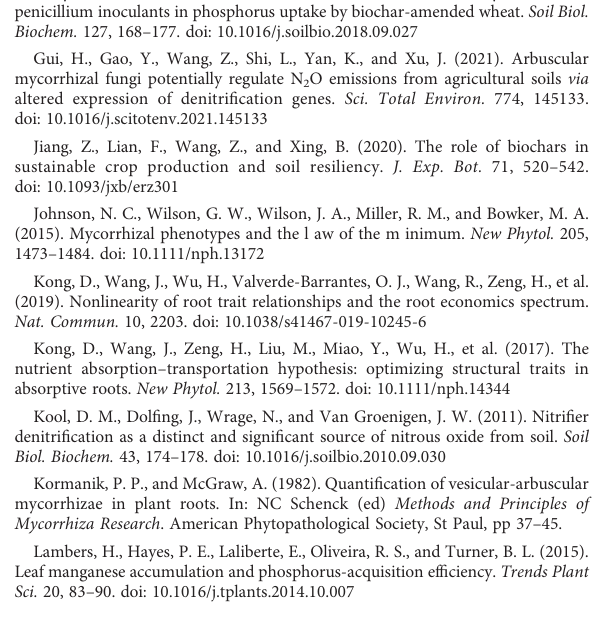
SUPPLEMENTARY TABLE 1 Primers used in qPCR. Note: R=A or G; S=C or G.